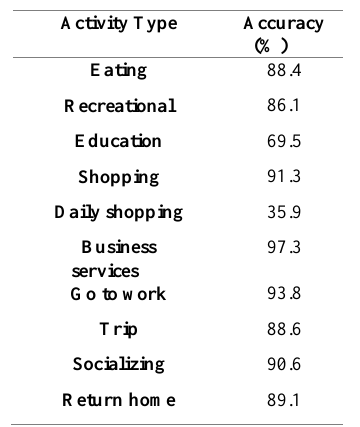
Table 10. Accuracy of extracted activities using user’s feedback.